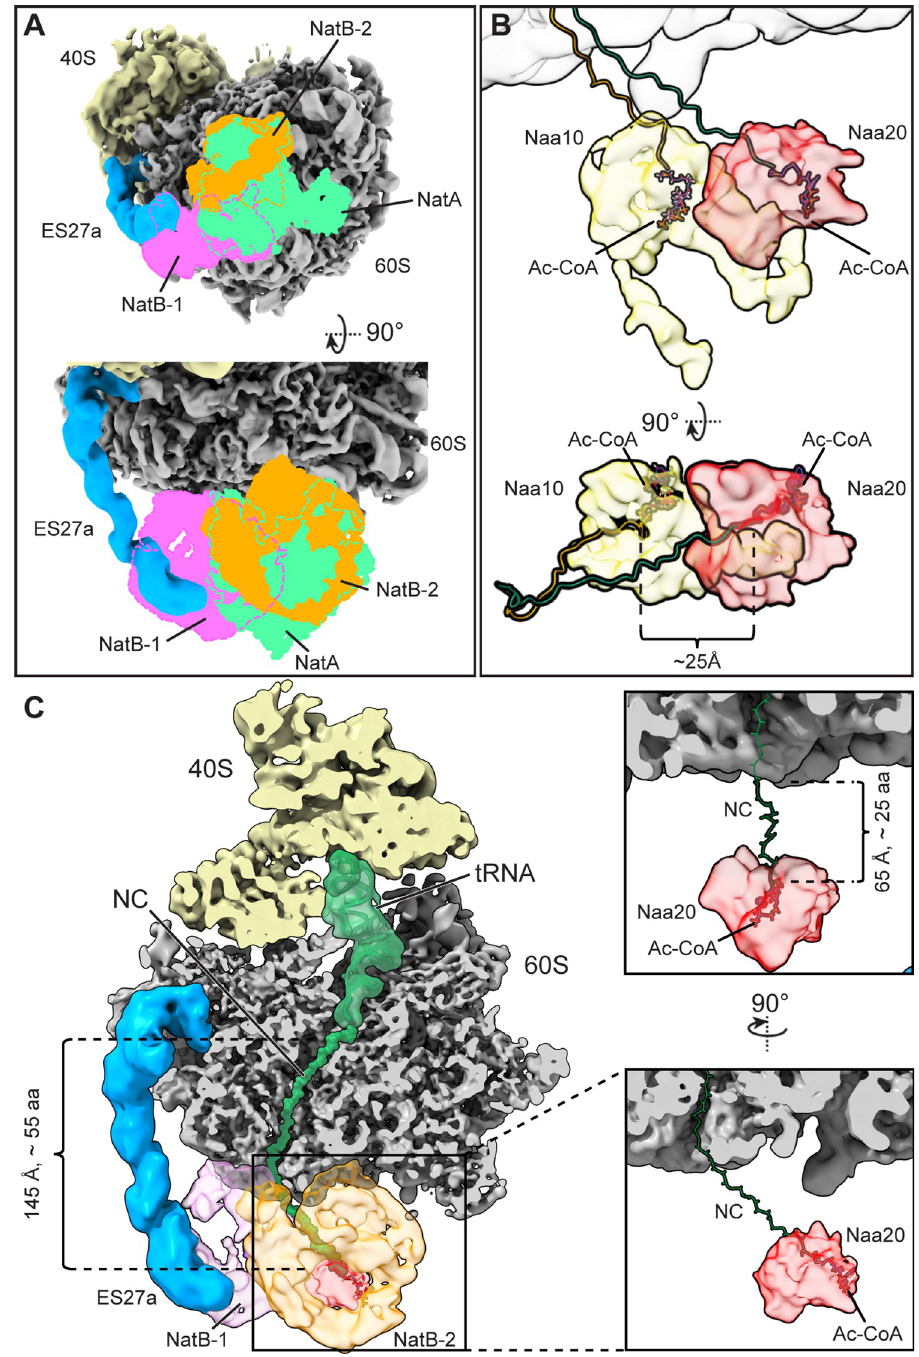
Fig 3. Comparison of ribosome-bound NatB and NatA complexes. ( A ) Bottom view (upper panel) and front view (lower panel) showing an overlay of the NatB-1 (pink) and NatB-2 (orange) ribosome structure with isolated densities for ribosome-bound NatA (bright green) (EMD-0201; [25]). ( B ) Comparison of positions for the NatA and NatB-2 catalytic subunits (Naa10 and Naa20) with respect to the 60S subunit shown as front and top view. The position of acetyl-CoA (Ac-CoA) and a putative model for the nascent chains is shown. For clarity, only Naa20 of NatB-2 is shown. ( C ) Left panel: cut front view of the NatB ribosome cryo-EM map highlighting the nascent polypeptide chain and the position NatB-1 and NatB-2 (left panel). Right panels: Zoom-in views highlighting the catalytic Naa20-2 subunit and illustration of the minimal distance that a nascent chain has to span to reach the active site of Naa20-2.